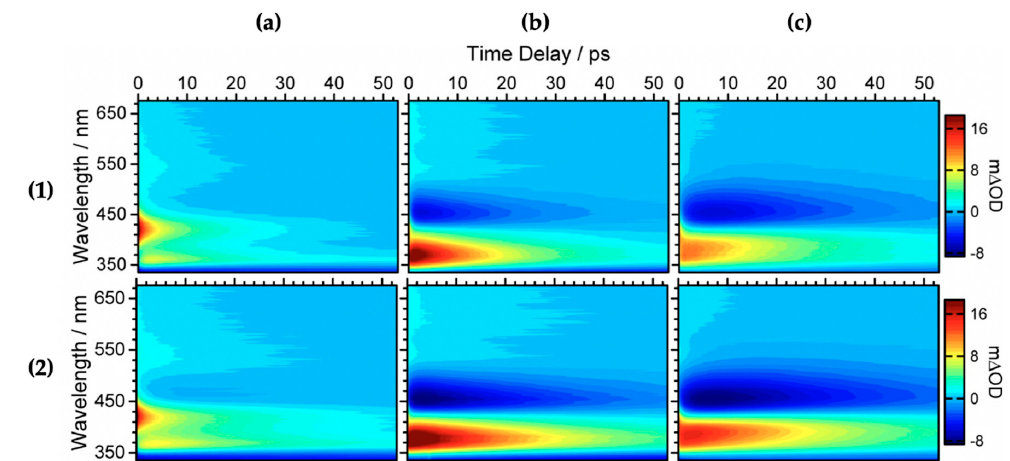
Figure 3. Transient absorption spectra (TAS) displayed as false colour maps of (1) SA and (2) SM in ( a ) dioxane, ( b ) acetonitrile and ( c ) methanol, respectively. Reproduced and adapted with permission from [104], licensed under CC-BY. © 2015 American Chemical Society.